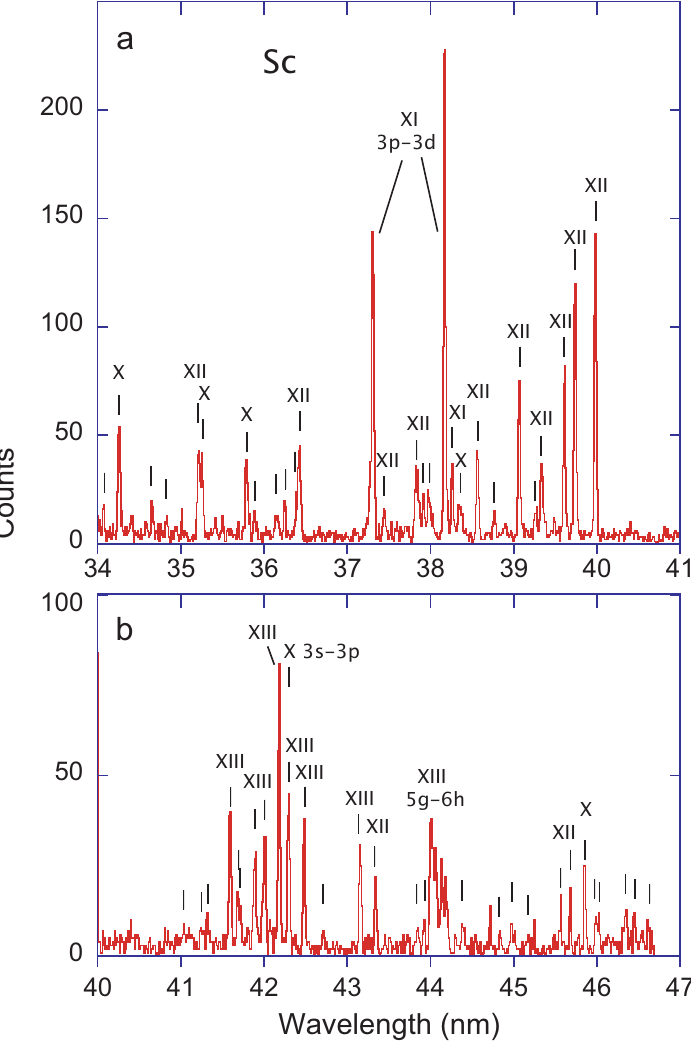
Figure 6. Two sections a,b of a beam-foil spectrum of Sc recorded at an ion beam energy of 23MeV. The strongest lines are identified by the spectrum number. Observation at the foil. Line width (FWHM) 0.03nm. The wavelength coverage of this spectrum corresponds largely to the spectrum in